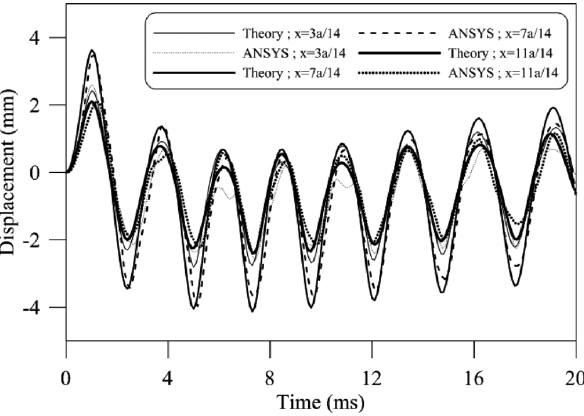
Fig. 21. The displacement-time histories of the simply-supported tapered laminated plates ( β = 1.2) for the stacking sequence [UCBGBC] S with [90/0/90] S . The minimum de fl ection and strain are obtained for the taper ratio of β = 0.2. The maximum discrepancy between two methods occurs for the negative peak value of [UCBGBC] s plate with the taper ratio of β = 1.2 at the point of x = 11 a /14. These results show that the predicted values are becoming closer to the FEM results as the taper ratio is decreased. The predicted peak values of strains by using the present method are found to be slightly higher for the point of x = 11 a